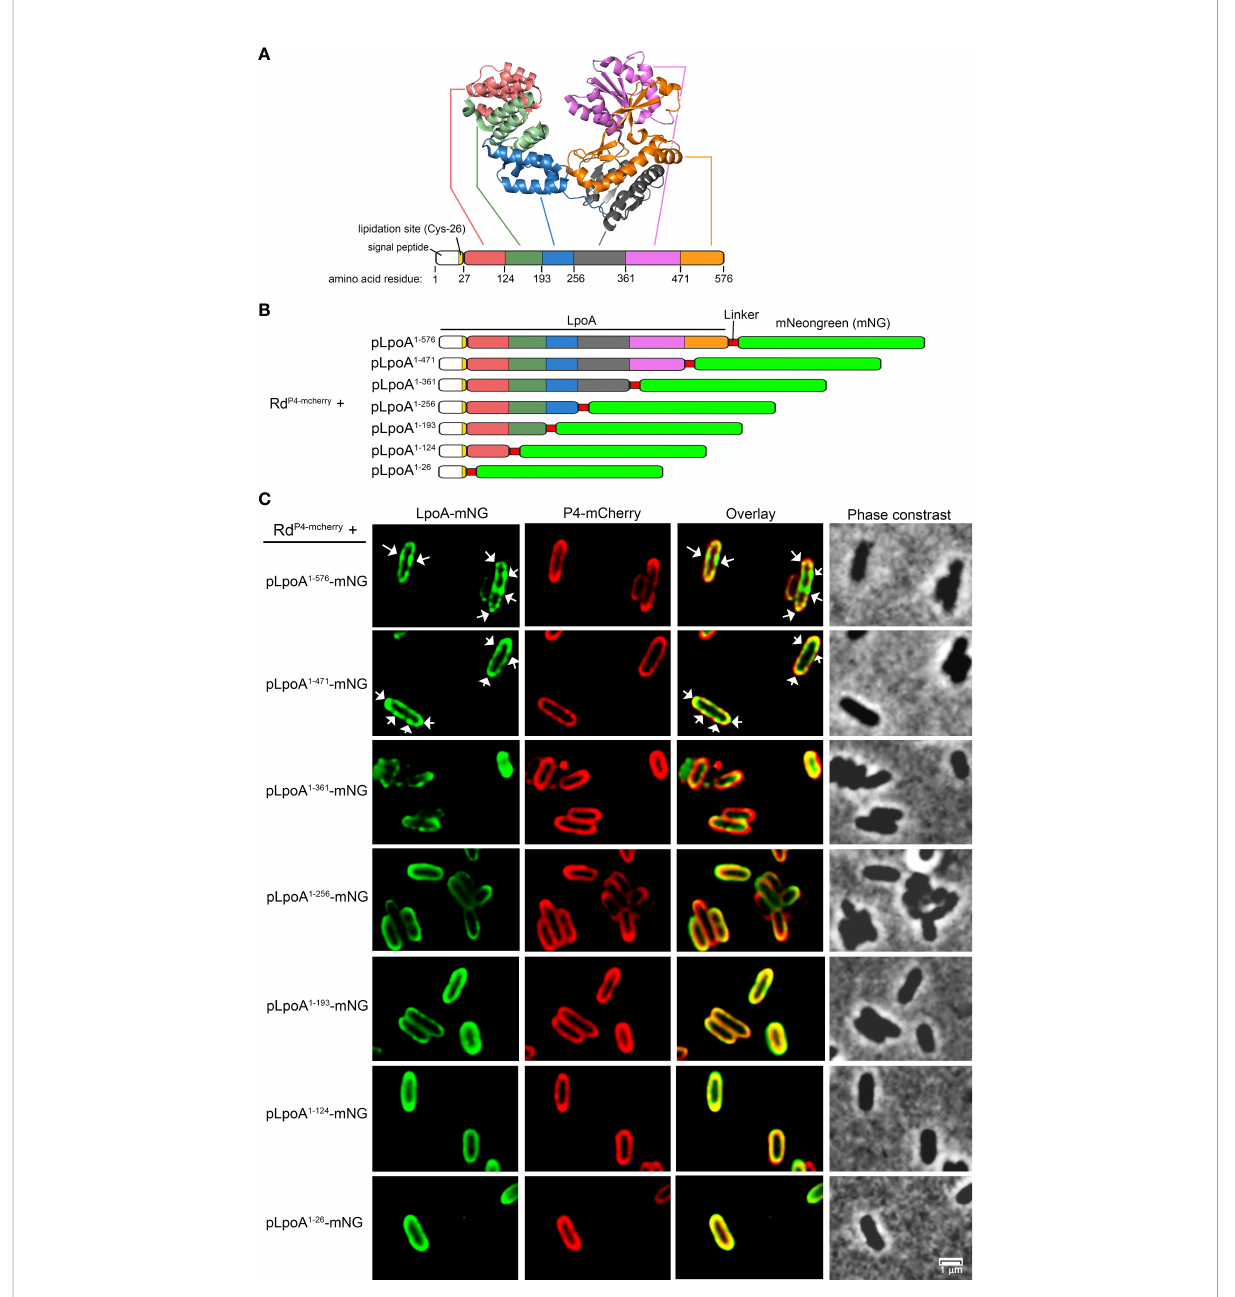
FIGURE 5 Fluorescence microscopy of H. in fl uenzae simultaneously producing the outer membrane-retained OMP P4-mCherry different and various truncated LpoA-mNeonGreen variants. (A) Crystal structure of H. in fl uenzae LpoA prepared in Pymol shows our arbitrary division of the lipoprotein into 6 domains and the corresponding amino acid residues. (B) Schematic representation of sequentially C-terminally truncated LpoA variants fused to mNeonGreen (mNG). The truncated LpoA constructs were introduced into the strain H. in fl uenzae Rd P4 mcherry to produce the strains stated in the left column. (C) Phase contrast and fl uorescence imaging of the strains indicated in panel (B) . White arrows indicate concentration of LpoA-mNG in foci in the OM (C) . All images were taken at 100x magni fi cation. Scale bars indicate 1